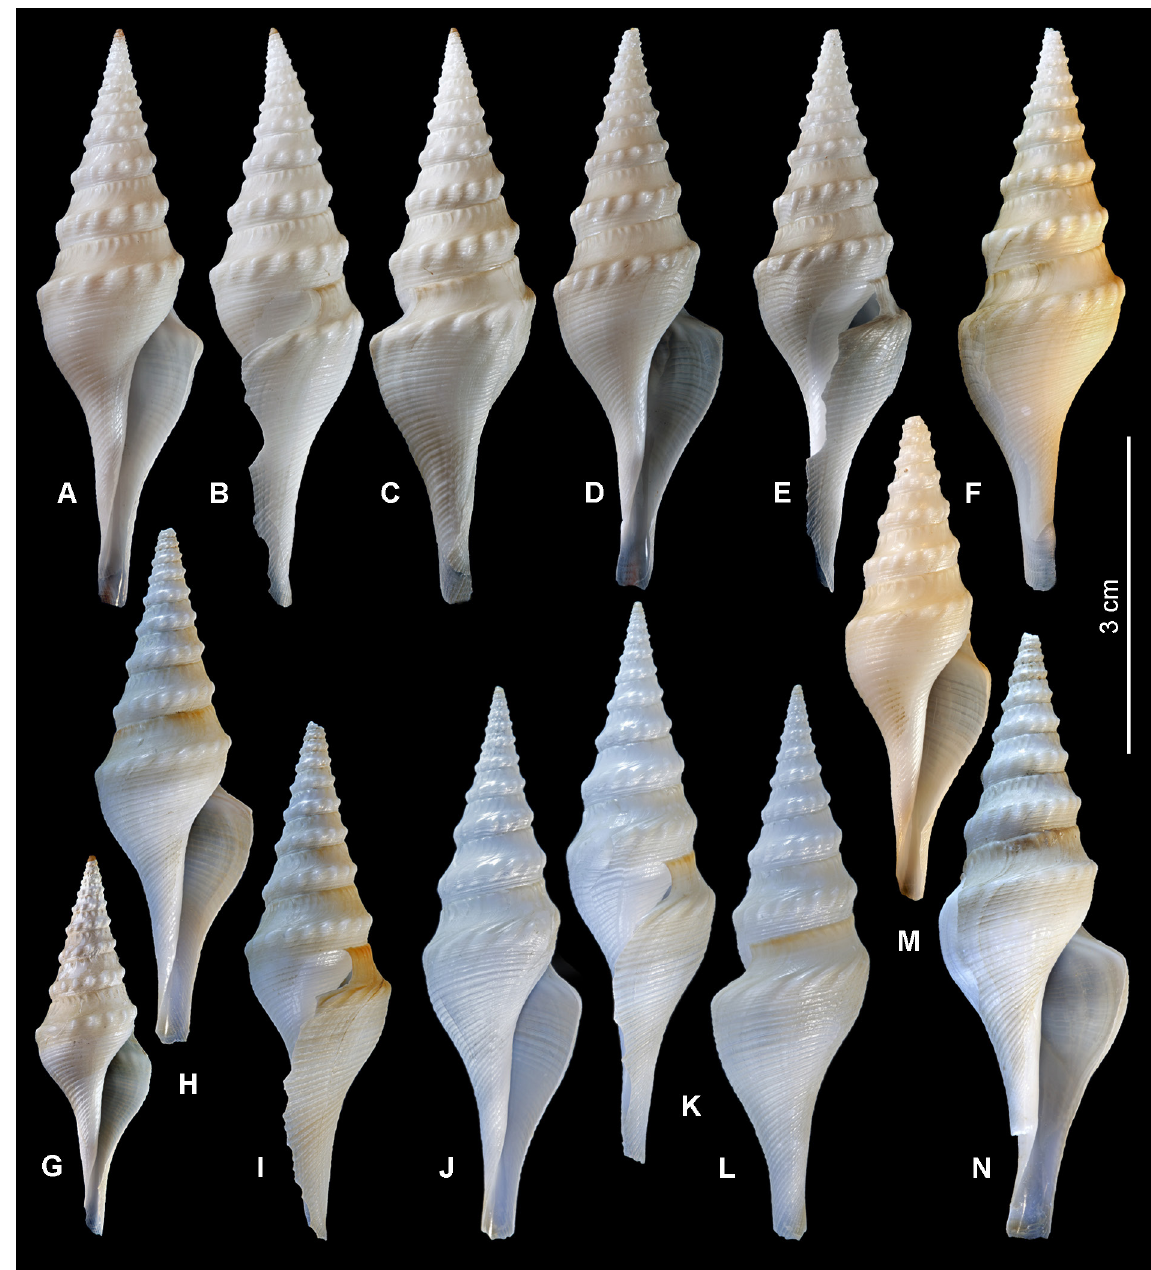
Fig. 6. Sibogasyrinx subula sp. nov. A–C . Solomon Islands, holotype, MNHN-IM-2007-42530,